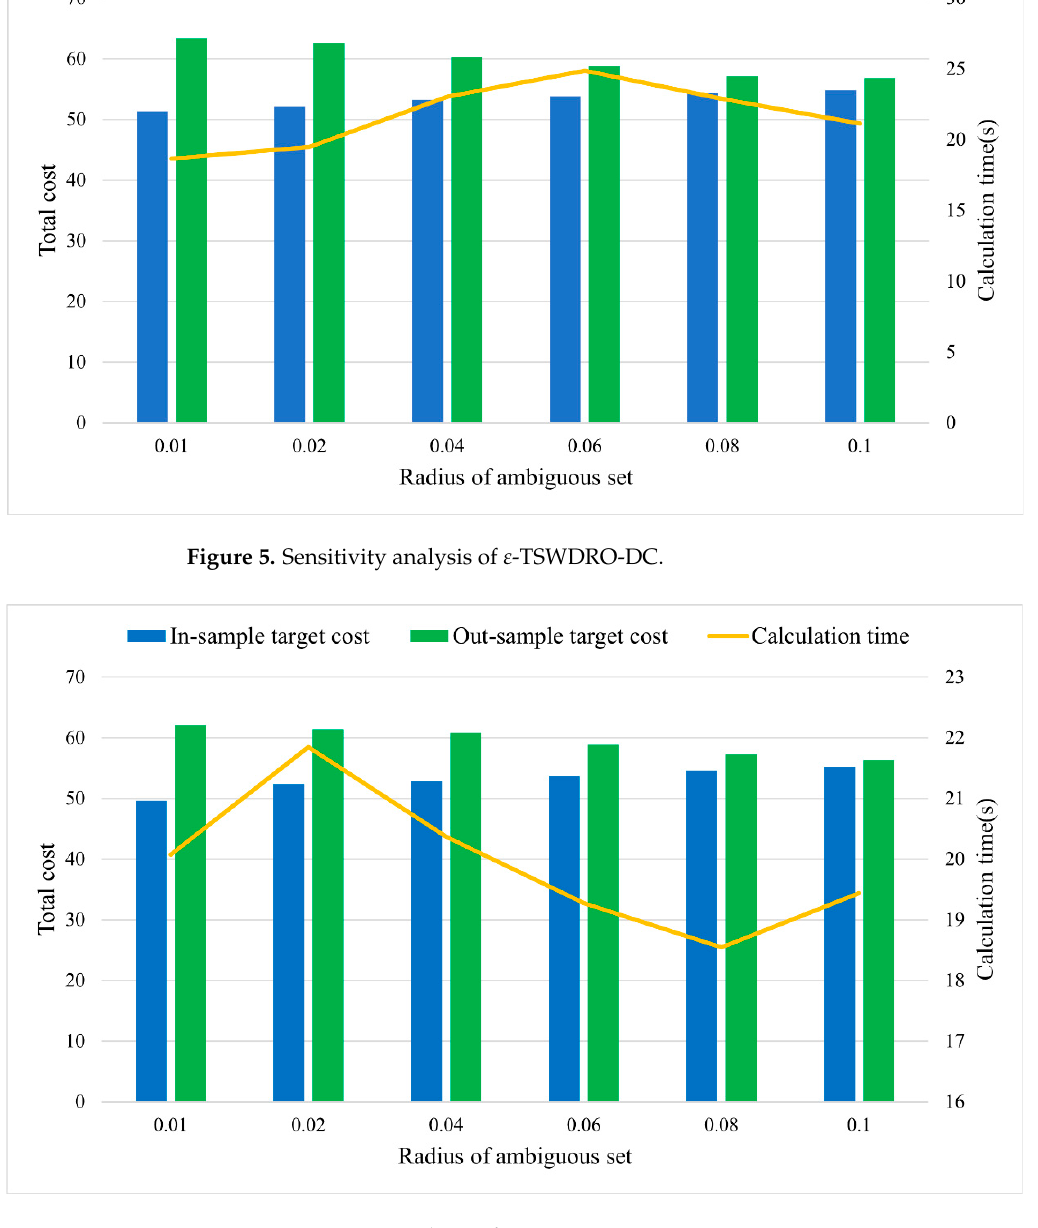
Figure 6. Sensitivity analysis of TB-TSWDRO-DC.